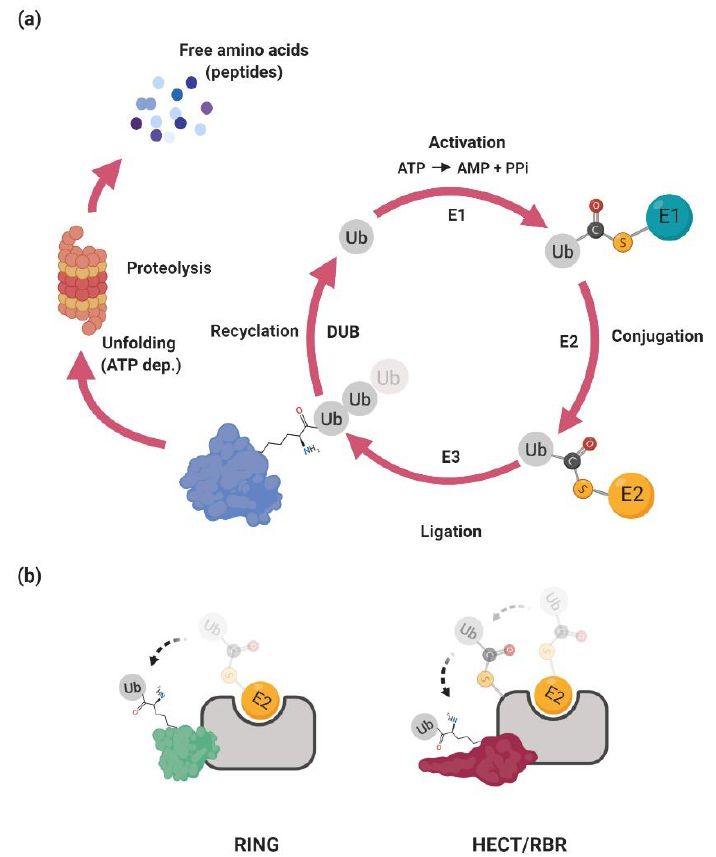
Figure 1. The ubiquitin–proteasome system. ( a ) The mature free ubiquitin monomer protein is either recycled from the ubiquitinated substrate or cleaved from the polyubiquitin precursor. Both of these reactions are catalyzed by deubiquitinases (DUBs). Ubiquitin is then activated (E1), conjugated (E2), and finally ligated to the cognate substrate via ubiquitin ligases (E3). The polyubiquitinated substrate is later transferred to the proteasome, unfolded, and proteolytically degraded to small peptides or free amino acids. For more details see the text. ( b ) RING E3s catalyze the direct transfer of ubiquitin from E2 ∼ ubiquitin to the substrate. HECT (homologous to E6AP C-terminus), and RBR (RING-between-RING) E3s accept ubiquitin from E2 to form an E3 ∼ ubiquitin thioester intermediate via transthiolation reaction. For more details see the text.